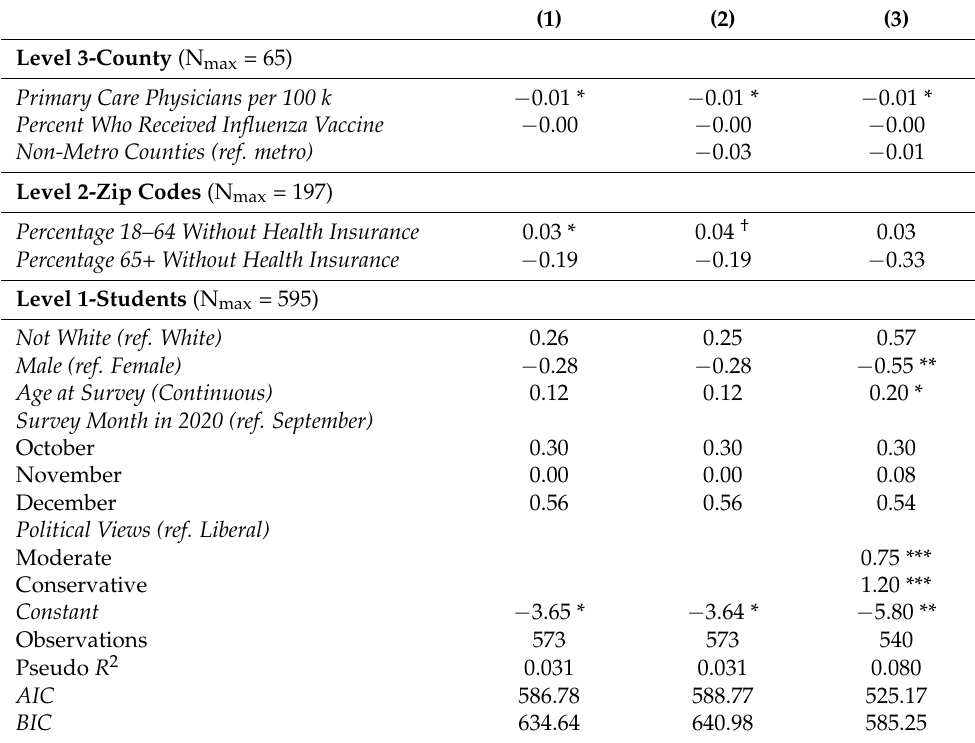
Table 4. Multi-Level Logistic Regressions Predicting the Log Odds of COVID-19 Vaccine Hesitancy among